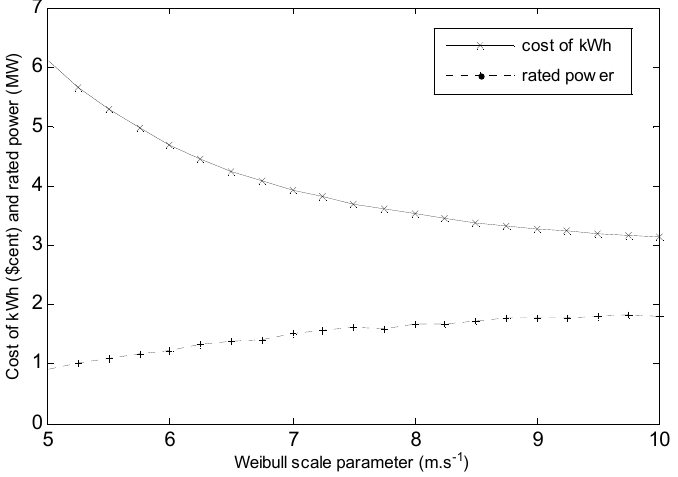
Figure 6. Variation of rated power in MW and cost per kW h in $cent with the Weibull scale parameter.